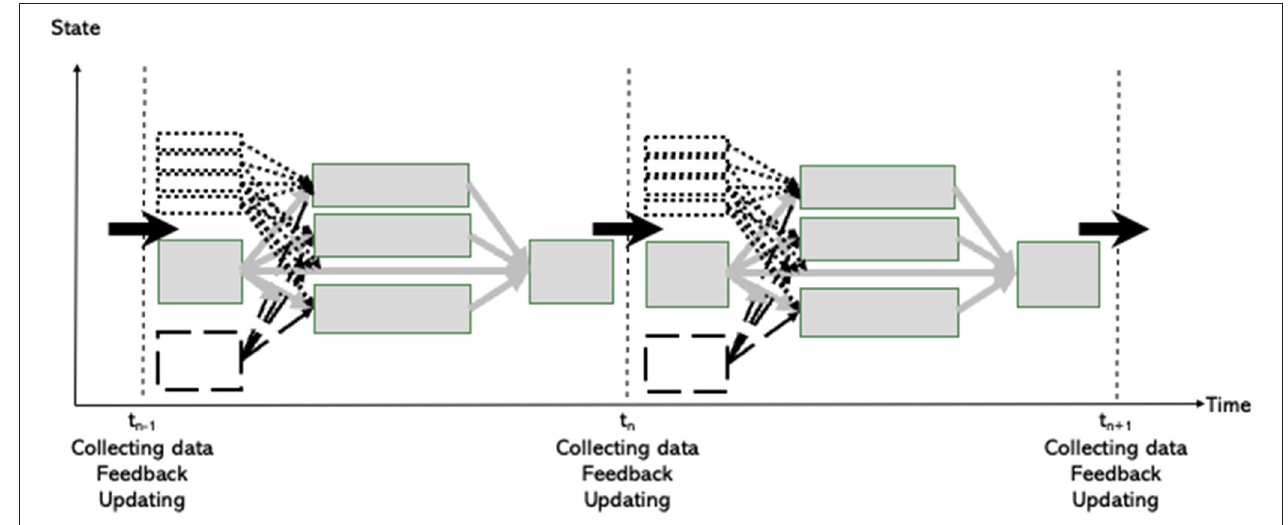
FIGURE 8 | The learning process evolving in